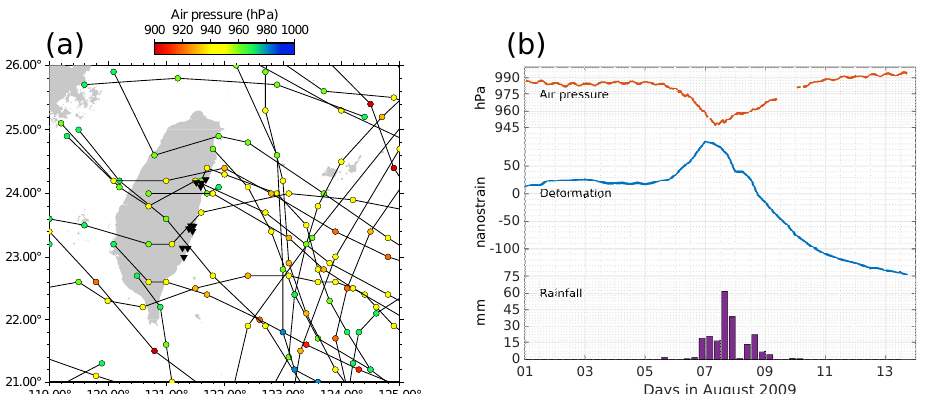
Figure 16. ( a ) Trajectories of typhoons and super typhoons in the Taiwan area between 2010 and 2019 [67]. The dots are colored according to the surface air pressure, reported every six hours. These tropical cyclones initiate in the east and move westward, either crossing Taiwan or running along its eastern coast. The strainmeter network (inverted black triangles) can monitor their effect on the crust. ( b ) Typical dilatation record (blue curve, middle) when a typhoon makes landfall, in this case typhoon Morakot (August 2009) observed at ZANB (signal is calibrated and detided). Note that we removed linear long-term trends that may run across several weeks before and after the typhoon, to focus on the typhoon process alone. The ground first expands (deformation increases) due to the air pressure drop (red curve, top) then contracts due to the precipitations (purple bar plot, bottom) that create a rainwater surface load.